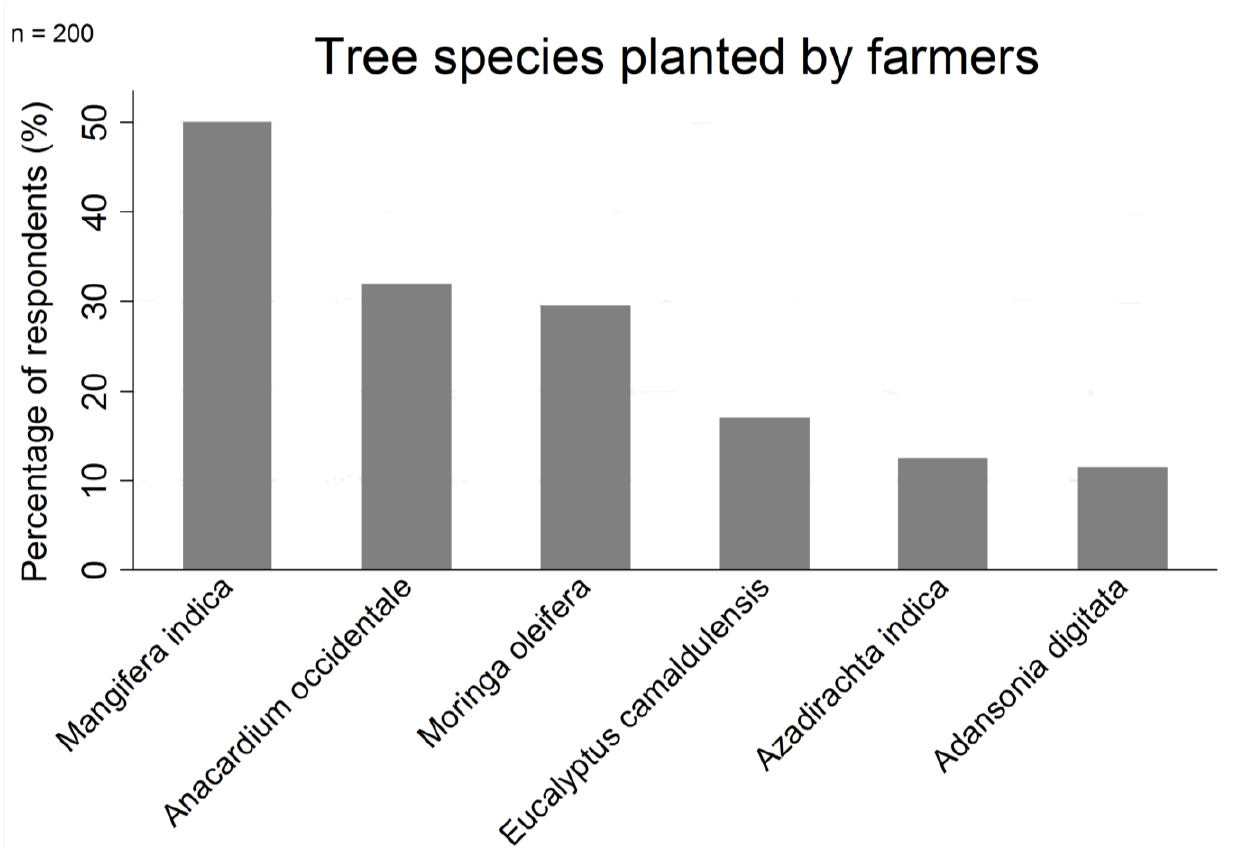
Figure 2. Proportion of the respondents planting the six selected